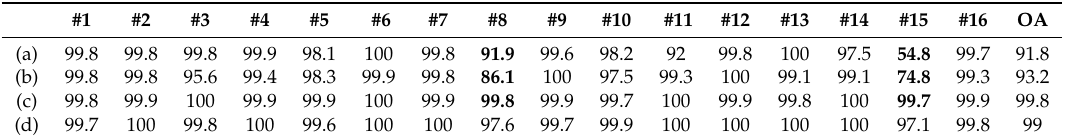
Table 2. Producer accuracy (%) on Salinas Valley HSI: (a): 1D-CNN with 204 bands, (b): BSCNN with 70 selected bands, (c): 1D-CNN with augmented input vectors of 645 bands, (d): 2D-CNN with input layer composed of one principal component from each pixel.